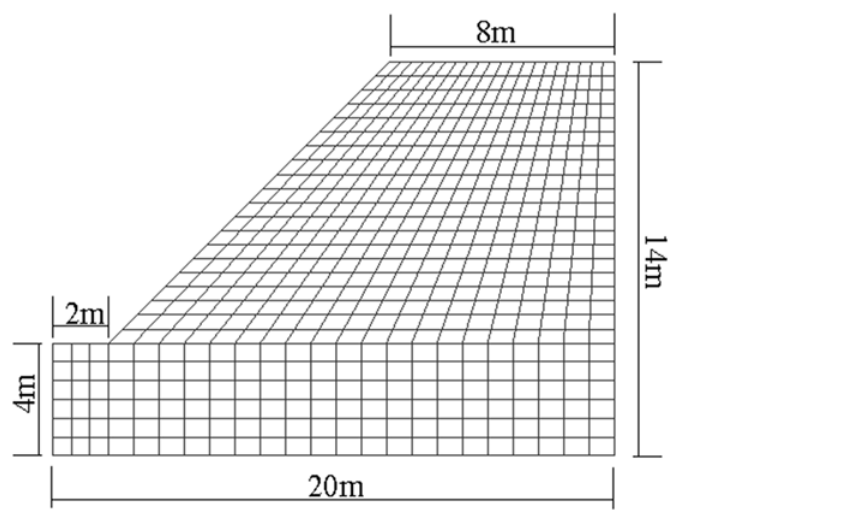
Fig 20. The model of non-homogeneous rock